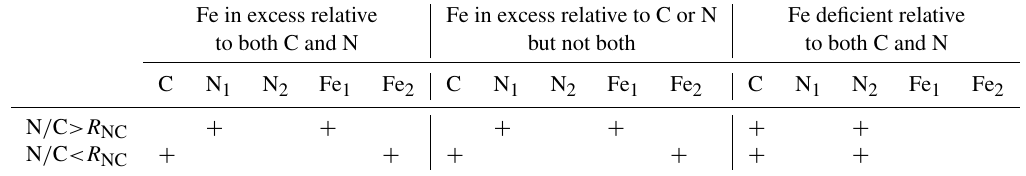
Table 2. Cases where the “excess” terms are nonzero. These terms are always greater than or equal to zero, and always zero when the phytoplankton elemental ratio is equal to the grazer biomass ratio. A plus ( + ) sign indicates that a specific term is positive. N 1 and N 2 , Fe 1 and Fe 2 indicate the first and second terms in Eq. (16b) and (16c). R NC is the grazer N / C (Redfield) ratio. Fe in excess relative Fe in excess relative to C or